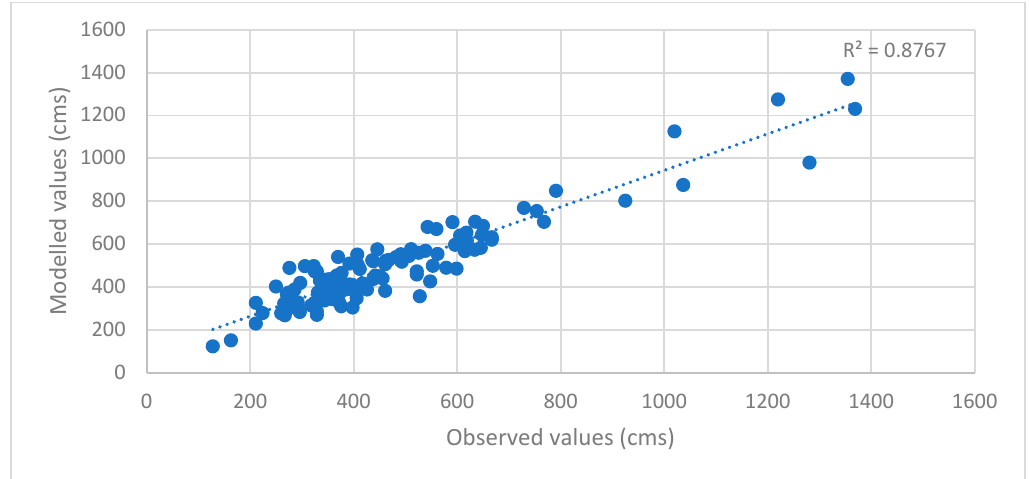
Figure A3. Correlation graph for gauge station “164 km above KapHES” with the R2 value.